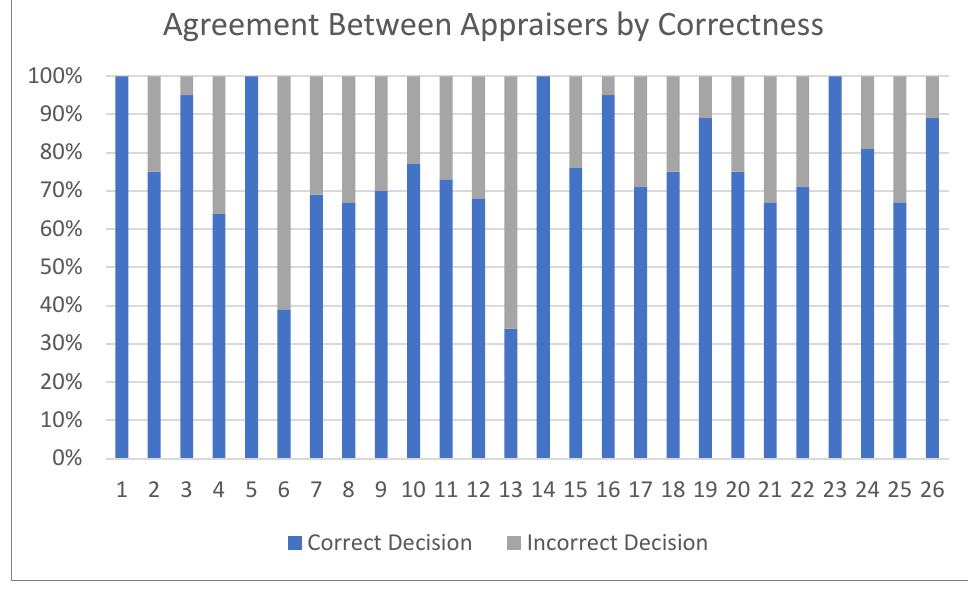
Figure 4. Agreement between appraisers by decision correctness. Data for static images only, without the usual ability to view the blade from different perspectives and tactile feeling of the blade.